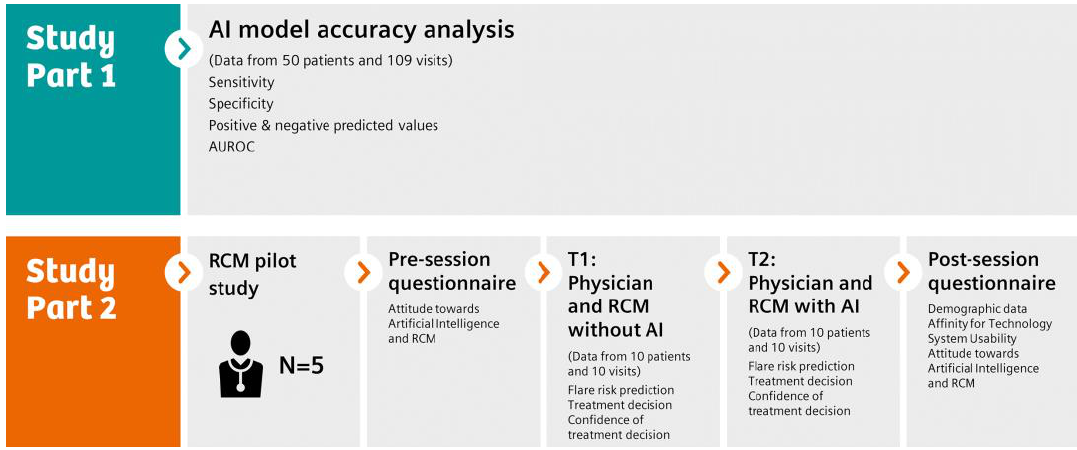
Figure 1. Flow chart of the study .